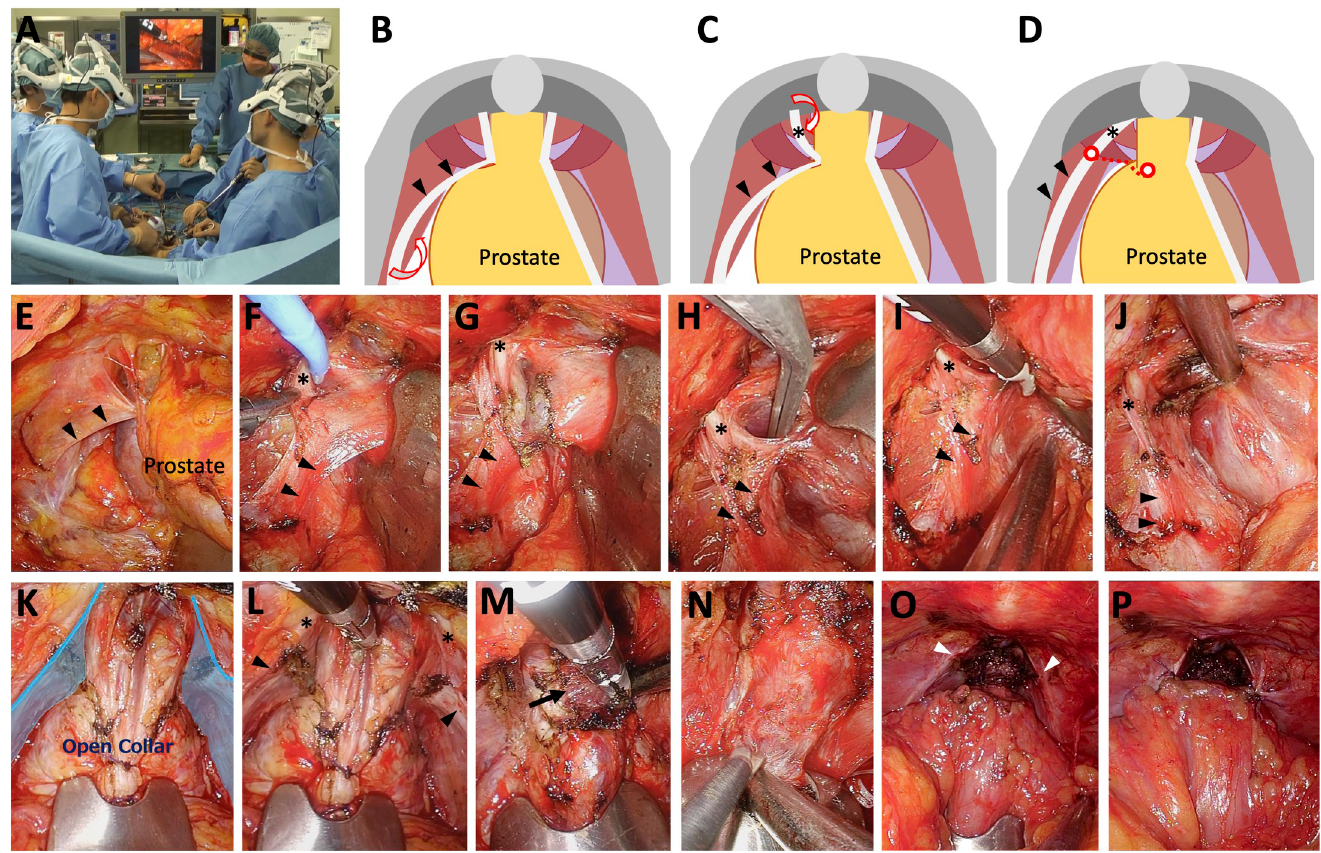
Fig 1. Surgical techniques for novel anatomical apical dissection and anterior reconstruction in gasless single-port retroperitoneoscopic radical prostatectomy. (A) The 3-dimensional head-mounted display system. (B-K) Puboprostatic open-collar technique. The surgical procedures consist of three steps: 1) Separating the endopelvic fascia (EF) lateral to the prostate (B), 2) separating the EF medial to the puboprostatic ligament (PPL) (C), and 3) transecting apical attachment of the pubococcygeus muscle (D). The EF is bluntly separated lateral to the prostate toward the apical attachment of the pubococcygeus muscle (B and E). Black arrowheads indicate preserved arcus tendinous (AT). Similarly, the EF is bluntly separated medial to the PPL, as indicated by an asterisk (C and F). The EF covering the apical attachment of the pubococcygeus muscle is incised to preserve the puboprostatic collar (D and G). Apical attachment of the pubococcygeus muscle (H) is transected using a bipolar sealing device (I). These procedures visualize the lateral aspect of the apical and urethral structures while preserving the puboprostatic collar (D and J). Open collar-shaped PPL-AT complexes (blue shadow) are preserved (K). (L and M) Sutureless transection of the dorsal vein complex (DVC). DVC is transected distally enough to secure apical surgical margins in cases of anterior apical tumor (L). The rhabdosphincter, indicated by an arrow, is exposed (M). (N) Retrograde urethral dissection. Overlying DVC tissues are retrogradely dissected from the rhabdosphincter and urethra toward the apex to secure apical surgical margins and to preserve the functional urethral length. The urethra is sharply divided. (O and P) Anterior reconstruction. Following vesico-urethral anastomosis, the detrusor muscle is anchored to the puboprostatic collar at its original apical attachment site (O) using a 3–0 Vicryl stich